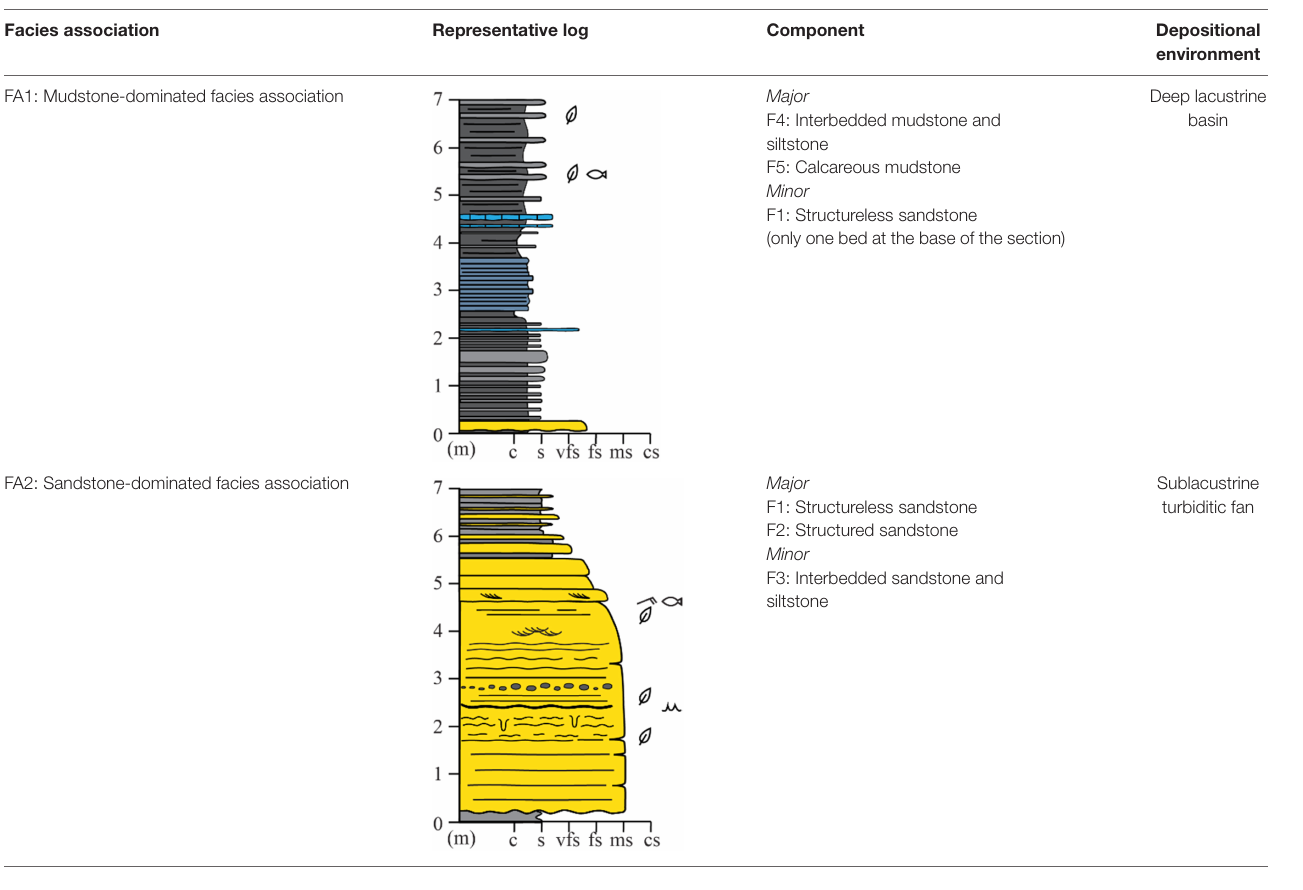
TABLE 3 | Summary of total, spectral gamma-radiation values, U/Th ratios and TOC contents of sedimentary facies. Sedimentary